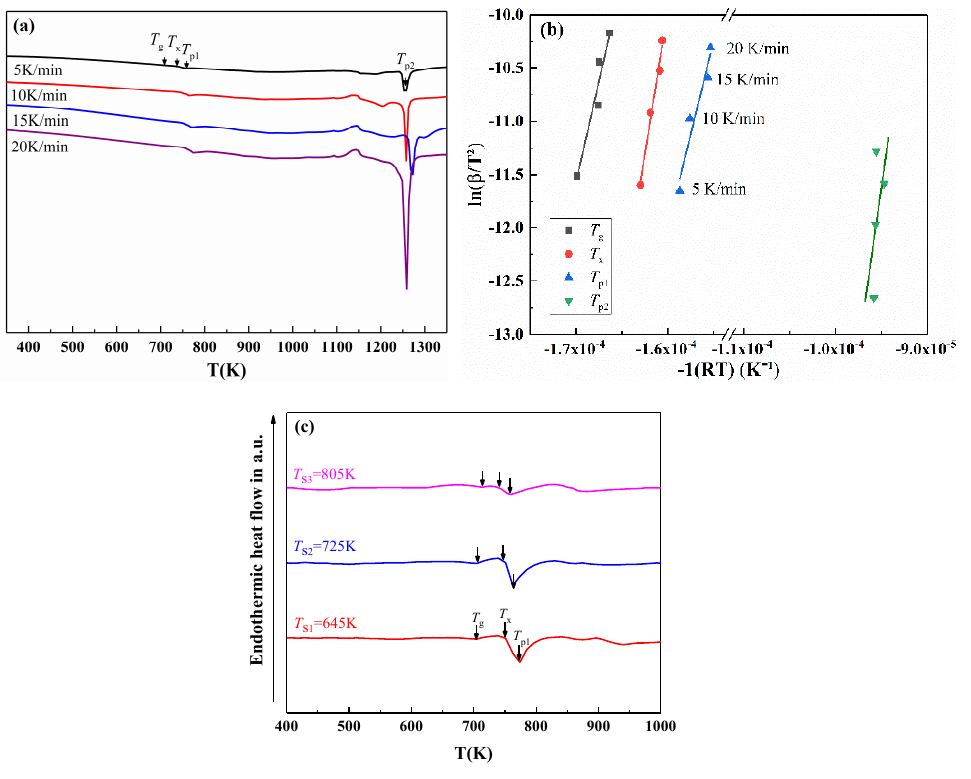
Figure 6. ( a ) DSC traces of (Cu 43 Zr 47 Al 7 Ag 3 ) 99.5 Co 0.5 amorphous powder, ( b ) the apparent activation energy of the powder, and ( c ) DSC traces at the heating rate 20 K/min of the coatings.